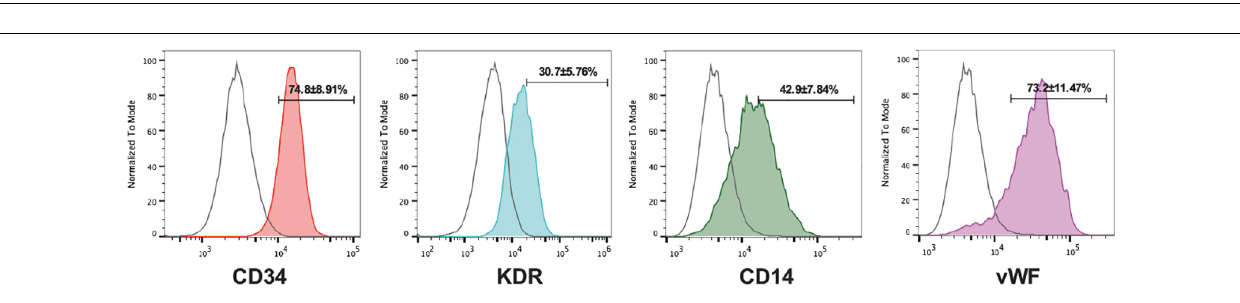
FIGURE 2 | Characterization of cultured EPCs. Flow cytometry analysis of the endothelial markers CD31, vWF, KDR, and the monocytic lineage marker CD14 of EPCs (IgG isotype control shown in red, n = 5 per group). Numbers are the mean ± SEM percentage of positive cells for all experiments determined by comparison with corresponding negative control